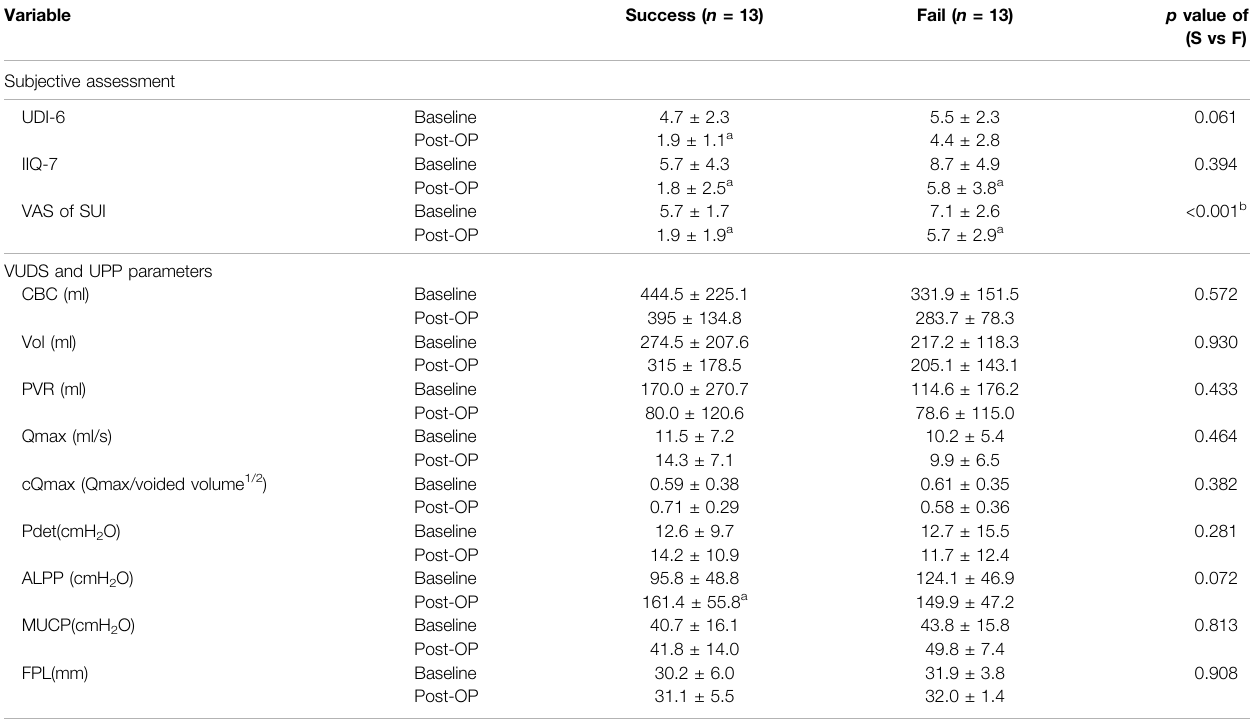
TABLE 4 | Comparison of the difference in subjective scores and urodynamic parameters before and after PRP treatment between the successful and failed subgroups.